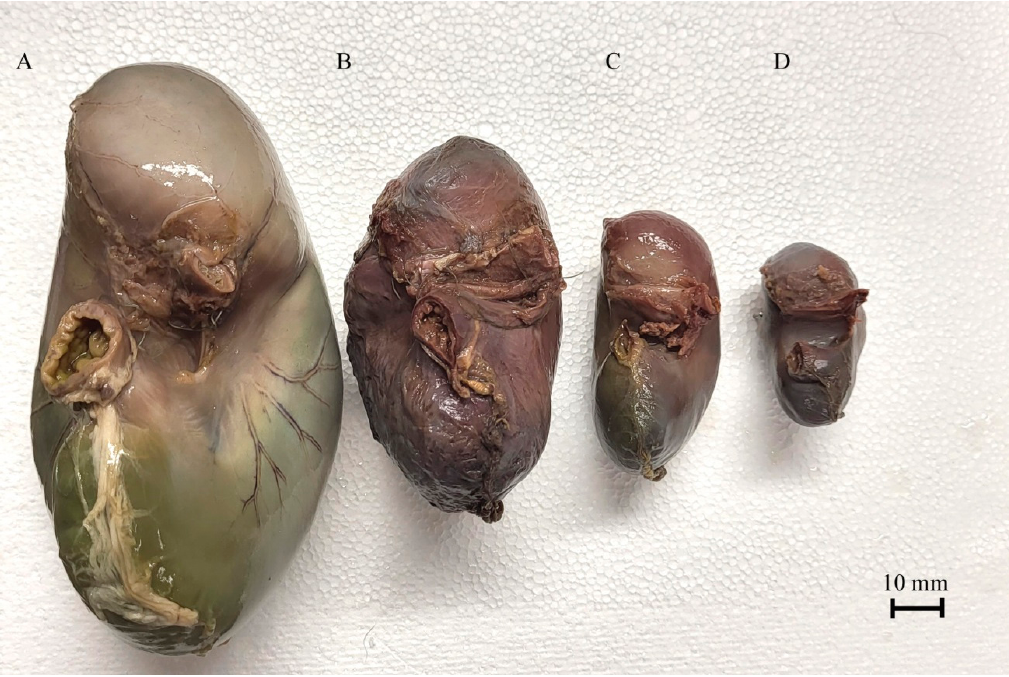
Figure 5. Equine fetal stomach (the lesser curvature view). A—the third age group, B—the second age group, C and D—the first age group.